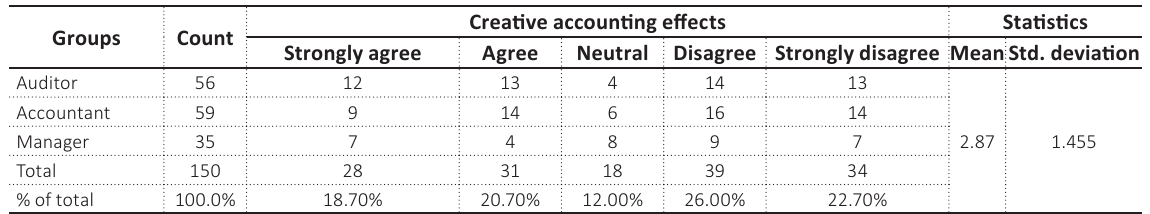
Table 2. Descriptive statistics on the effects of managers’ ethics on financial statements’ reliability